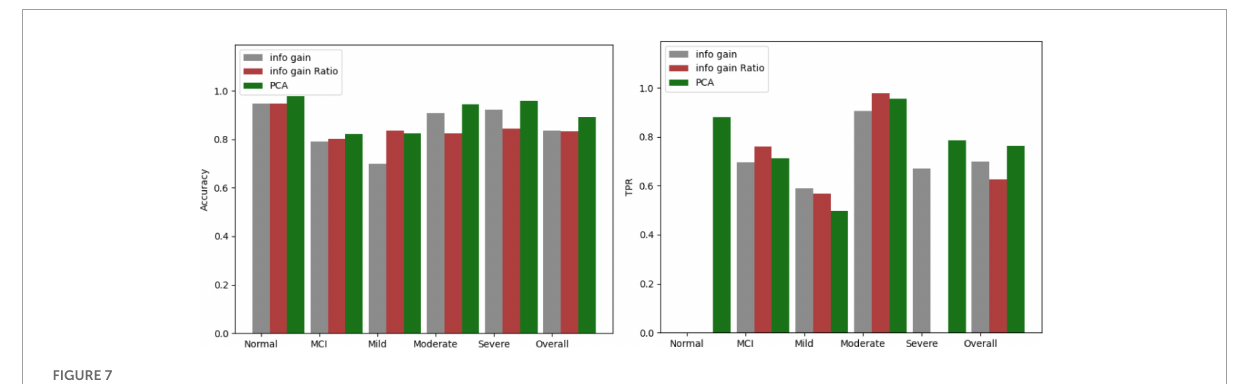
FIGURE7 Comparison results for 12